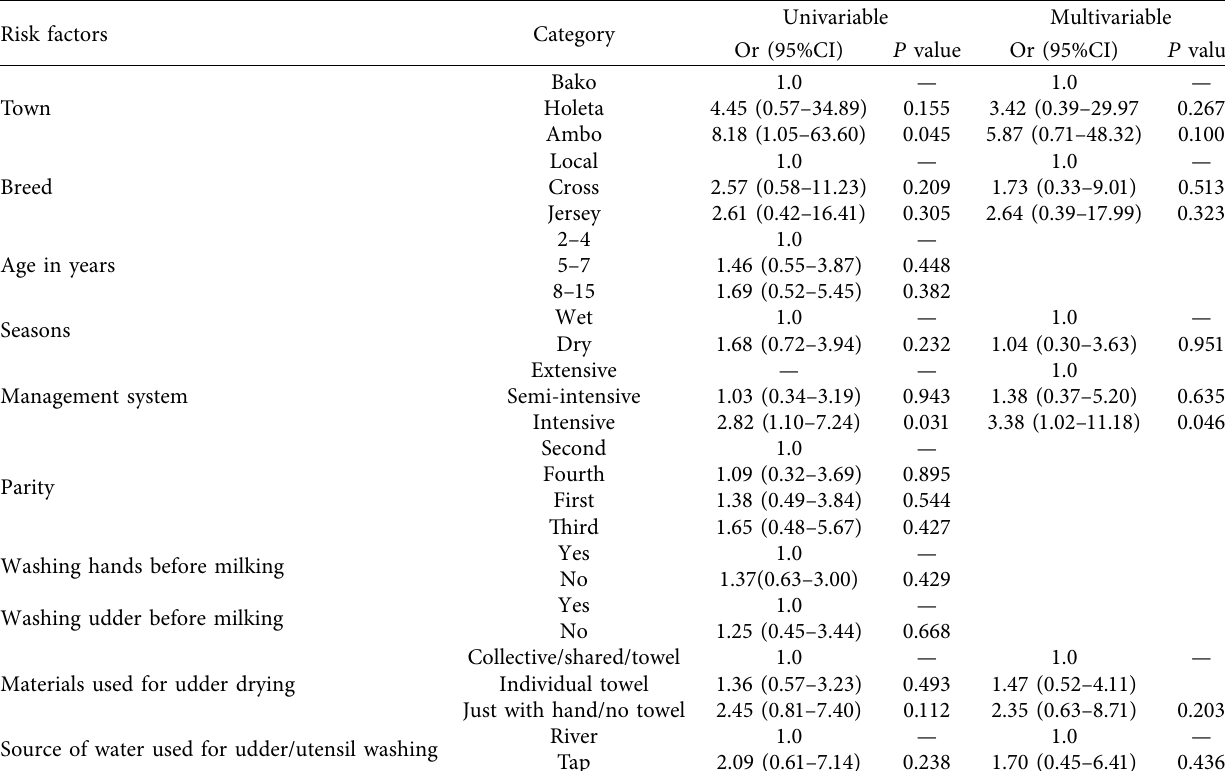
Table 4: Logistic regression analyses of potential risk factors for Listeria s pecies isolation rate in study towns at cow